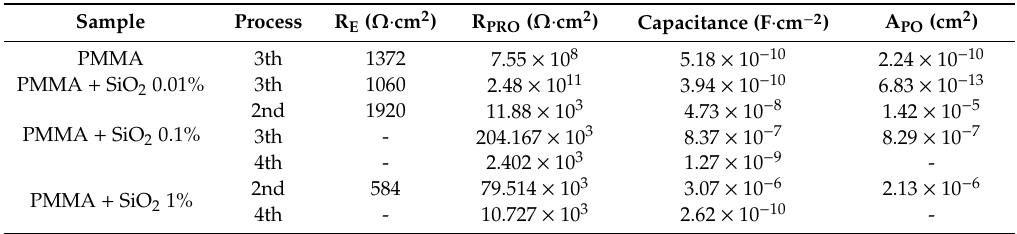
Table 1. Electrochemical impedance spectroscopy (EIS) parameters for the PMMA and PMMA + SiO 2 coatings in synthetic